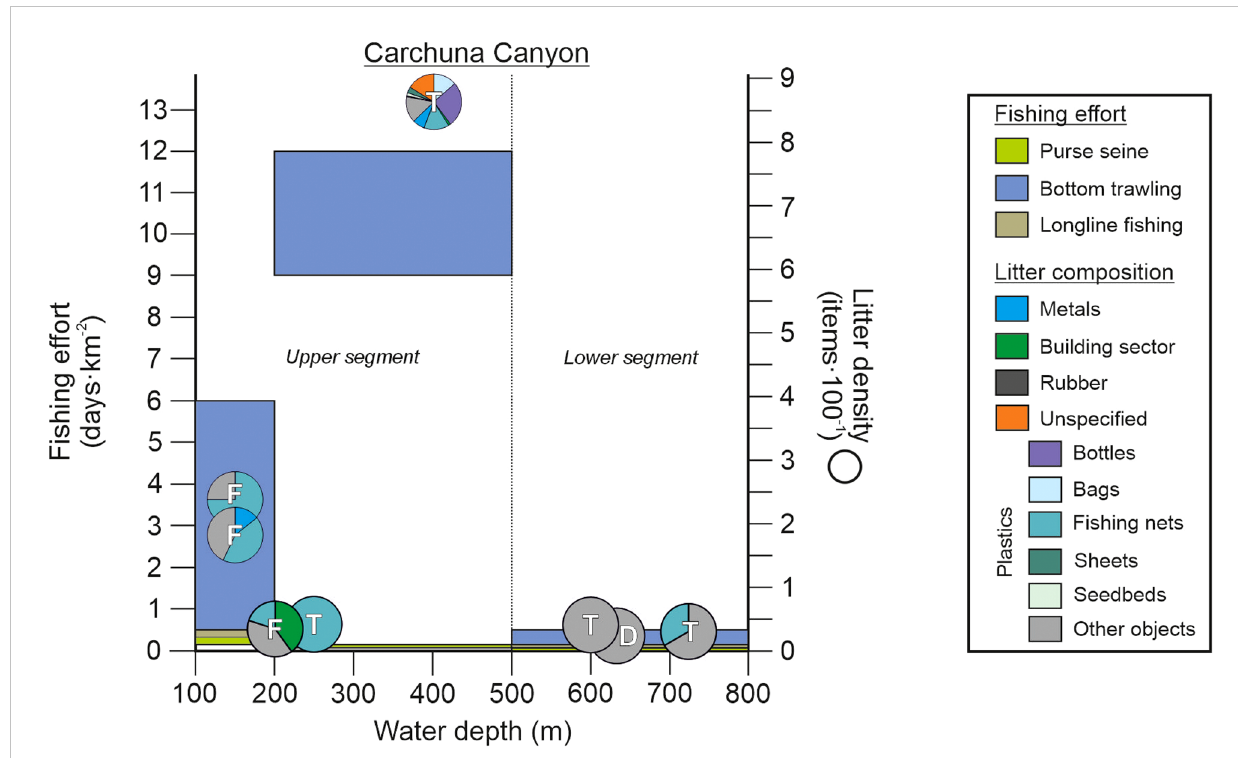
FIGURE 11 Chart showing the ranges of fi shing effort (days·km -2 ) for each of the Carchuna Canyon sections (see Figure 10). Litter density (expressed as number of items·100 m -1 ), and litter composition (as pie charts) are also shown. T, canyon thalweg; F, canyon fl ank; D, lateral